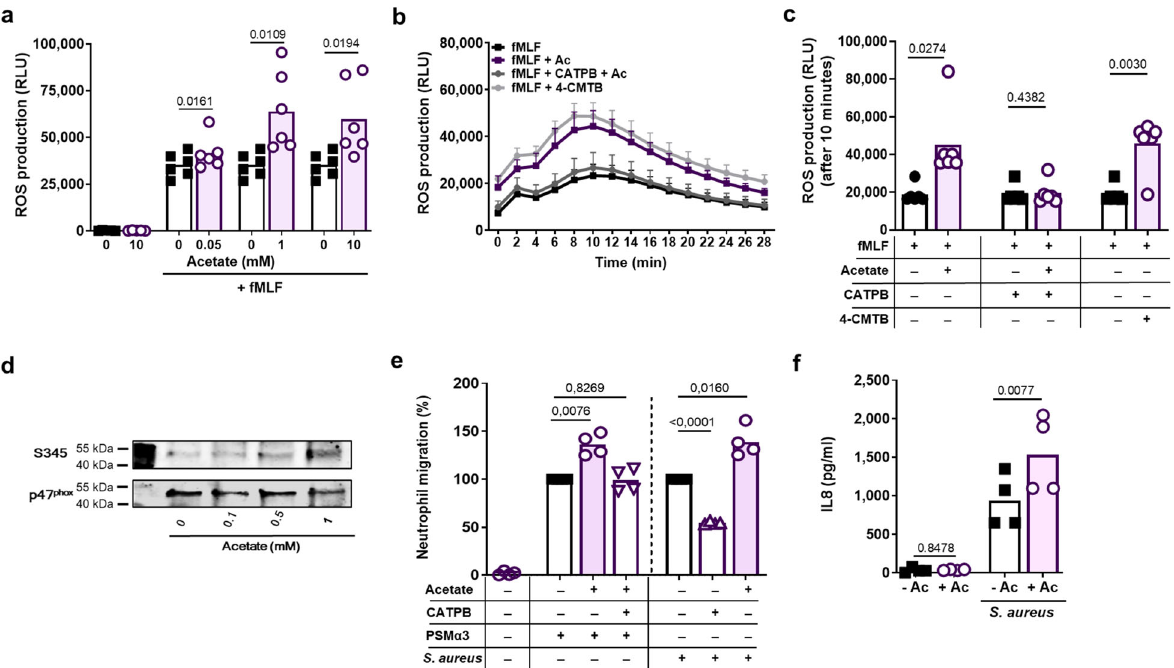
Fig. 1 Acetate primes neutrophils in a GPR43-dependent manner. Acetate enhanced the oxidative burst induced by ( a ) the FPR1 ligand fMLF (500 nM), which could be inhibited by the GPR43 antagonist CATPB ( b ). The same effect was caused by the synthetic GPR43 ligand 4-CMTB. ROS production was monitored by measuring relative luminescence units (RLU) emitted by ROS-responsive luminol ( c ). Incubation of neutrophils with acetate induced the priming-associated phosphorylation of the NADPH oxidase subunit p47 phox at serine position 345 (S345) ( d ). Migration of neutrophils towards the bacteria-derived chemoattractant FPR2 ligand PSM α 3 (500 nM) or towards live S. aureus cells ( e ), as well as release of the chemokine IL-8 in response to S. aureus challenge (both MOI of 1) were enhanced upon neutrophil priming with 1 mM acetate (Ac) ( f ). Data in panels a , c , e and f represent means of n = 6 ( a , c ) and n = 4 ( e , f ) independent experiments. Data in panel b represent mean ± SEM of n = 7 independent experiments. * P < 0.05; ** P < 0.01 ***P < 0.001, signi fi cant difference versus the indicated or non-acetate treated control (0 or - Ac) as calculated by paired two-tailed Student ’ s t test ( a , c , f ) or one-way ANOVA with Dunnett ’ s multiple comparisons test ( e ). d Shows one representative experiment out of